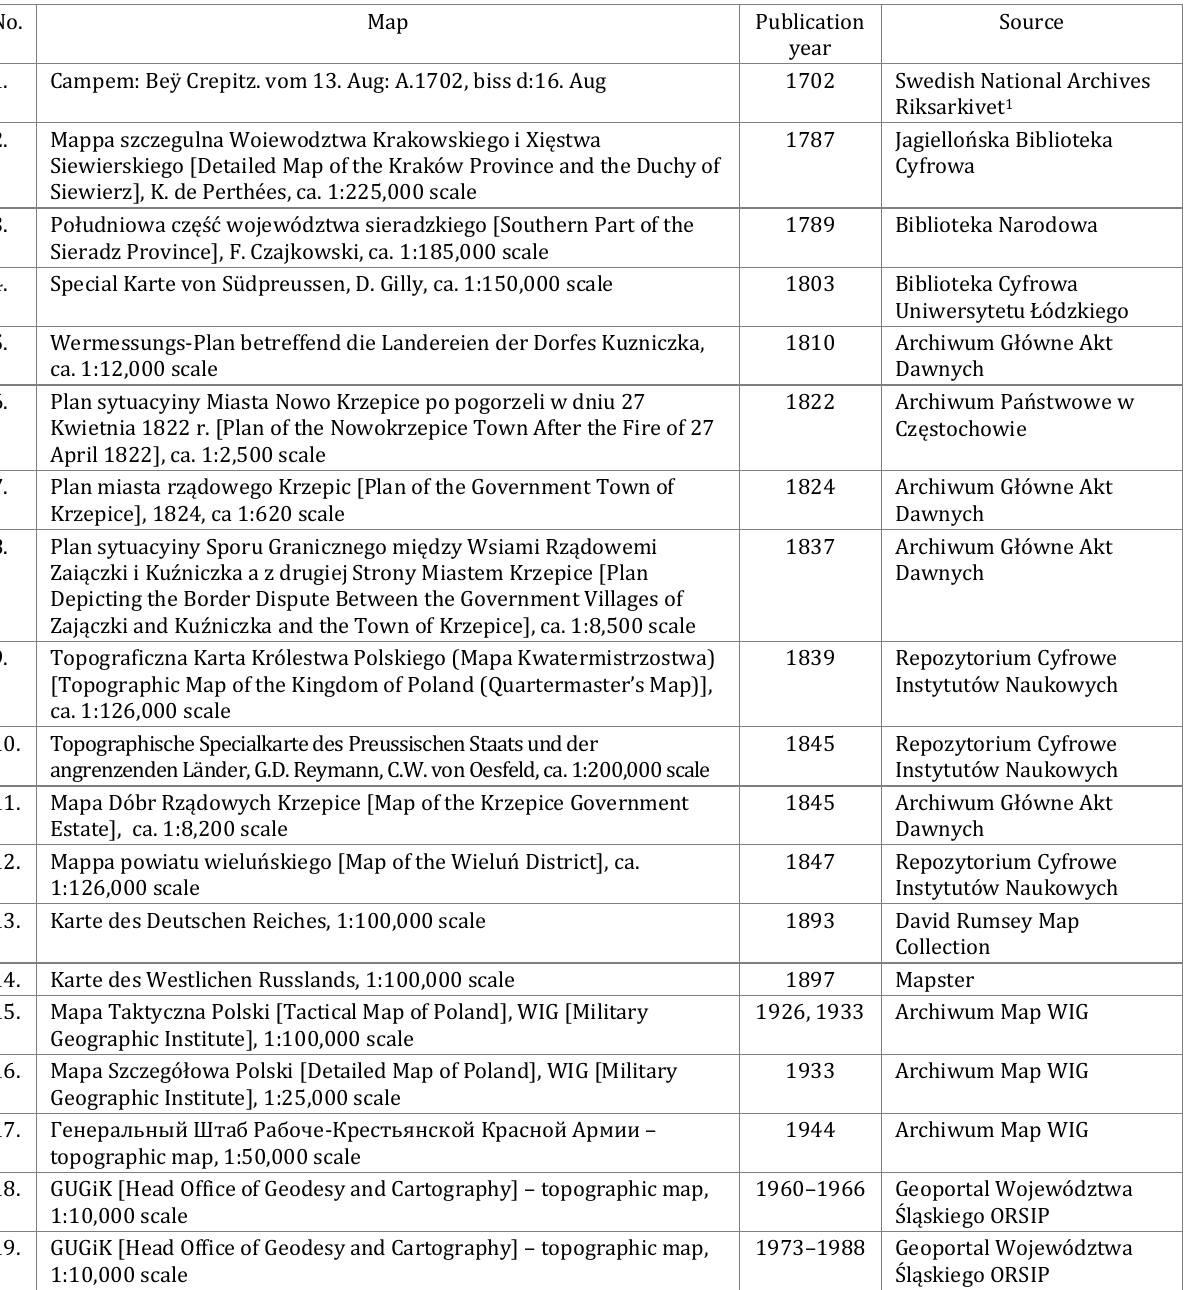
Table 1. Maps and plans used in the